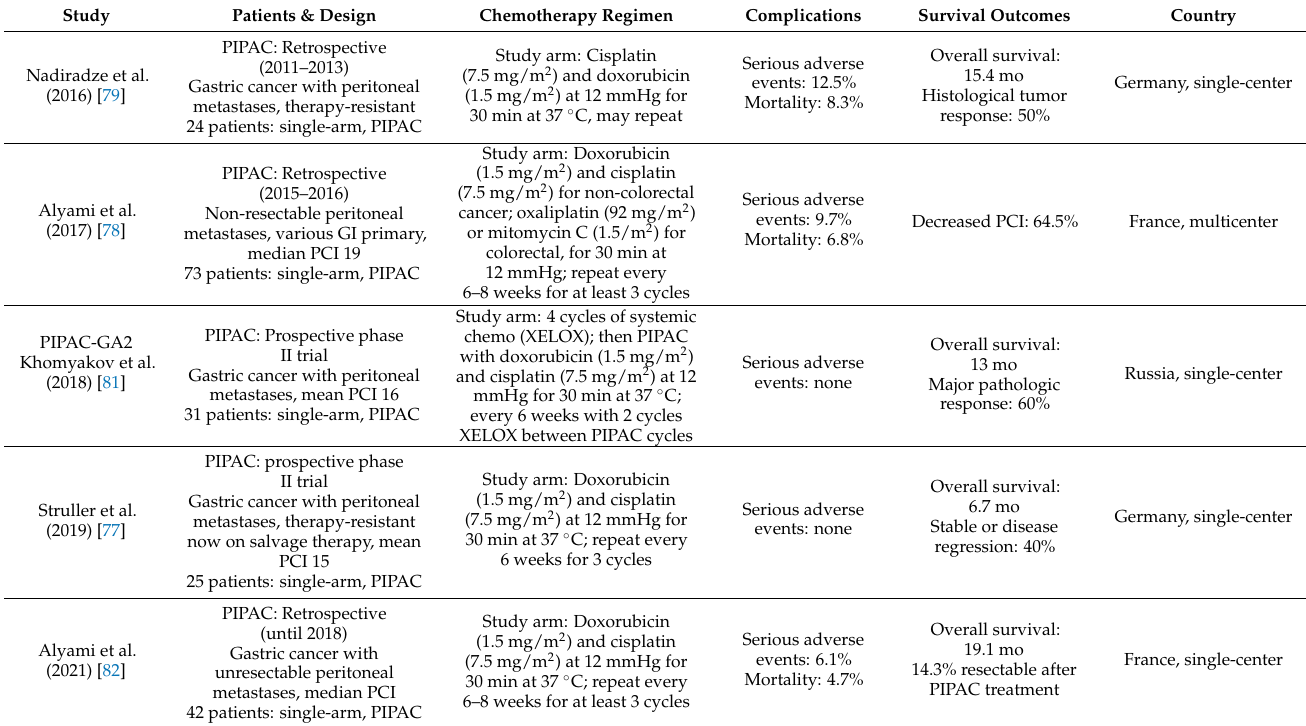
Table 2. Summary of Studies on Pressurized Intraperitoneal Aerosolized Chemotherapy in Gastric Cancer with Peritoneal